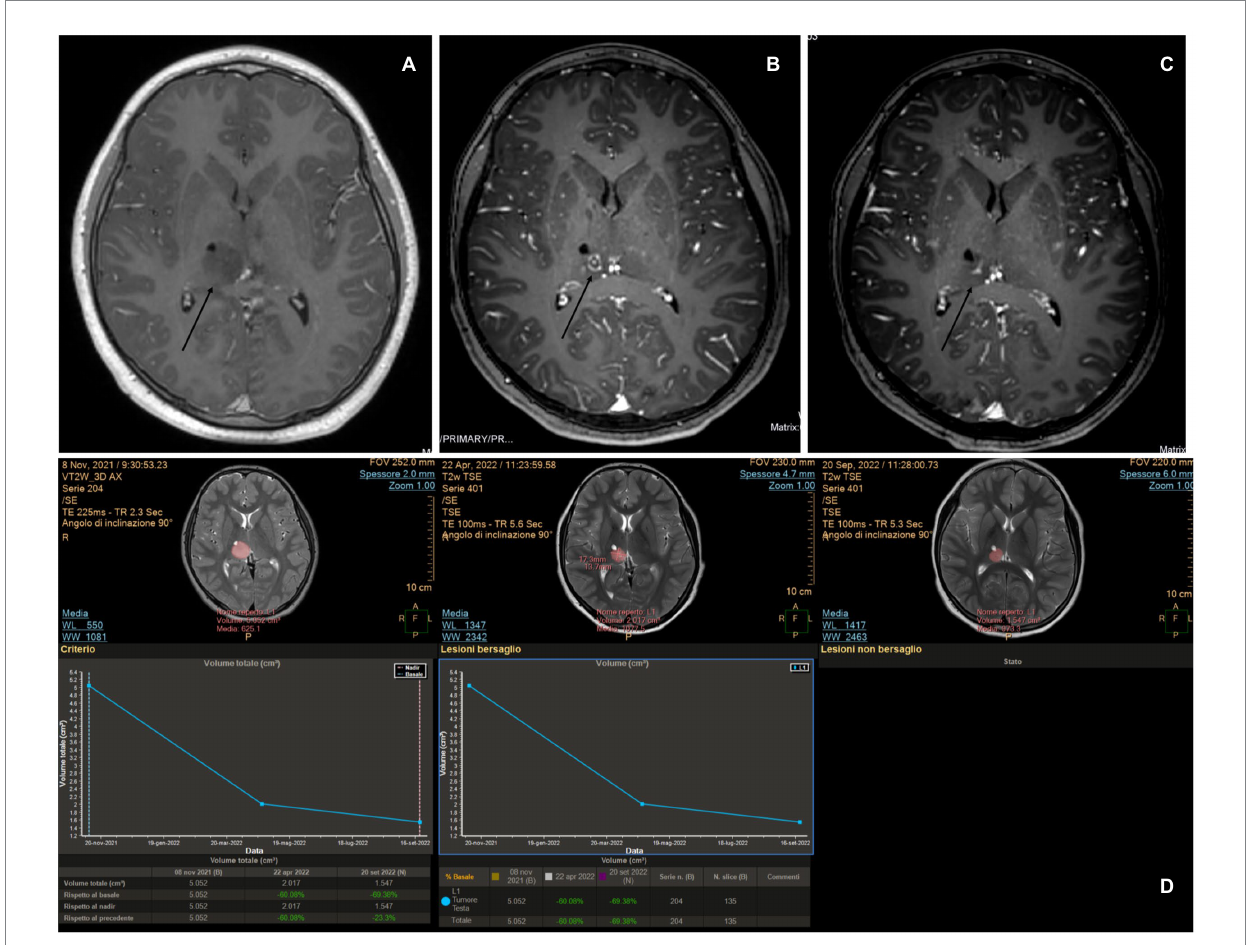
FIGURE 5 (A) Pre-operative magnetic resonance imaging (MRI) showing a right thalamic tumor with poor enhancement. (B) MRI obtained at 5 months revealed persistent blood–brain barrier damage, as suggested by the enhancement at the site where the tip of the laser diffusing fiber was located, and a surrounding ring enhancement on the border of the cone produced by the ablation thermal power exerted during the procedure. (C) MRI taken 10 months after the procedure still showed evidence of central enhancement. (D) MITT Intellispace Portal imaging revealed a volume reduction of 60% at 5 months and an overall reduction of 69% at 10 months.